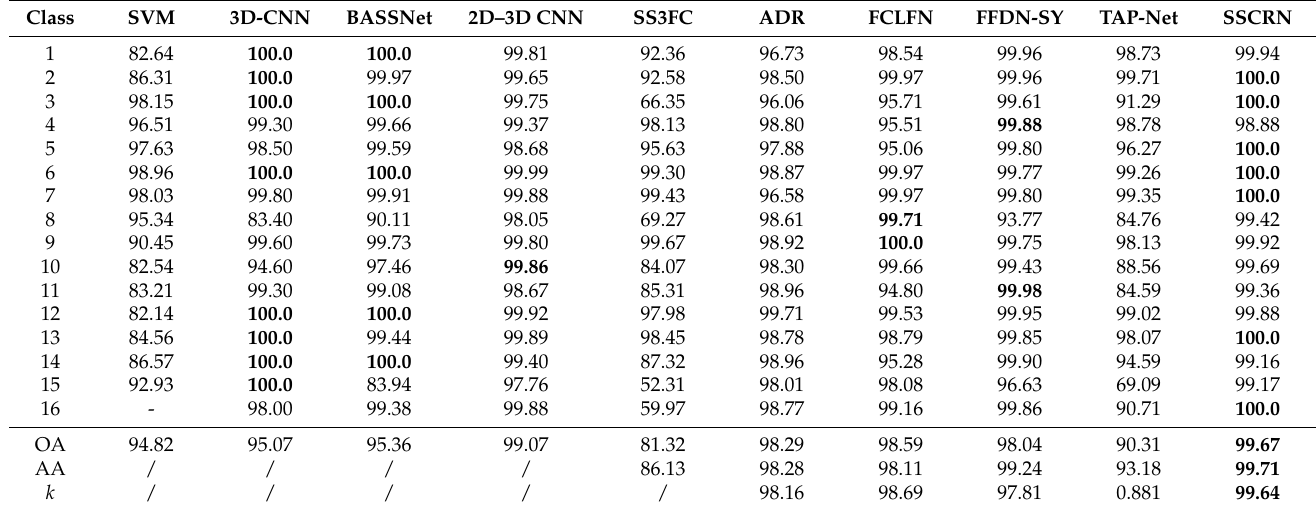
Table 8. Classification results (%) of different methods on the SA dataset. Bold indicates the best